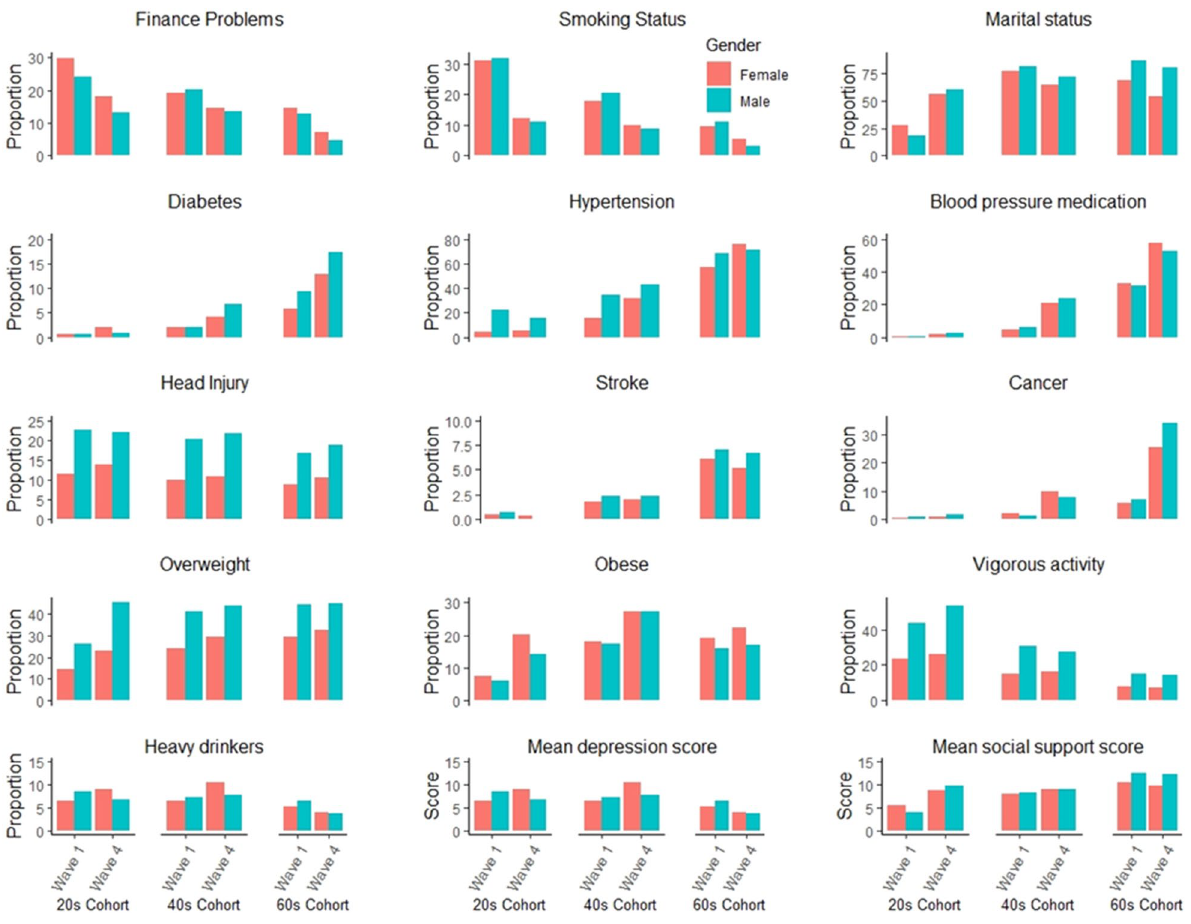
Figure 1. Prevalence of dementia risk factors at wave 1 and wave 4 in men and women in three